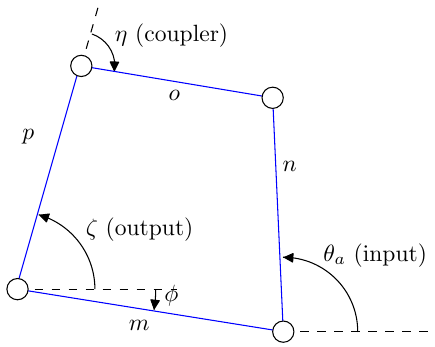
Figure 4. Modeling of a four-bar linkage.